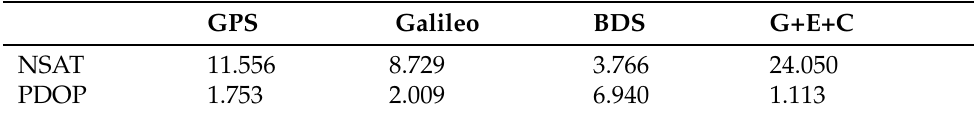
Table 1. Mean values of NSAT and PDOP for GPS, Galileo, BDS, and multi–GNSS (G+E+C) from 10